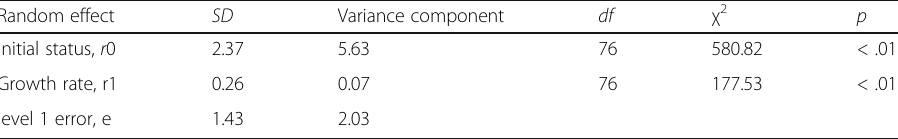
Table 3 Estimation of variance components for initial state and growth in self-efficacy Random